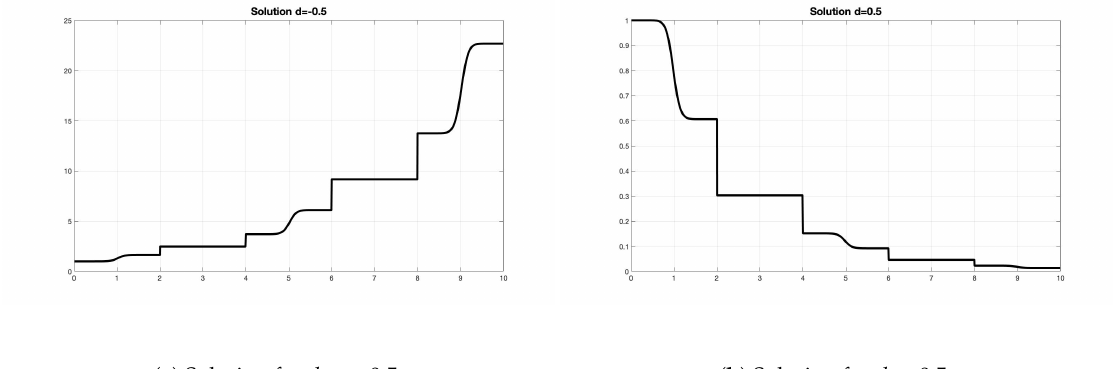
Figure 2. Explicit solution for different values of d and x 0 = 1 (vertical lines represent jumps in the